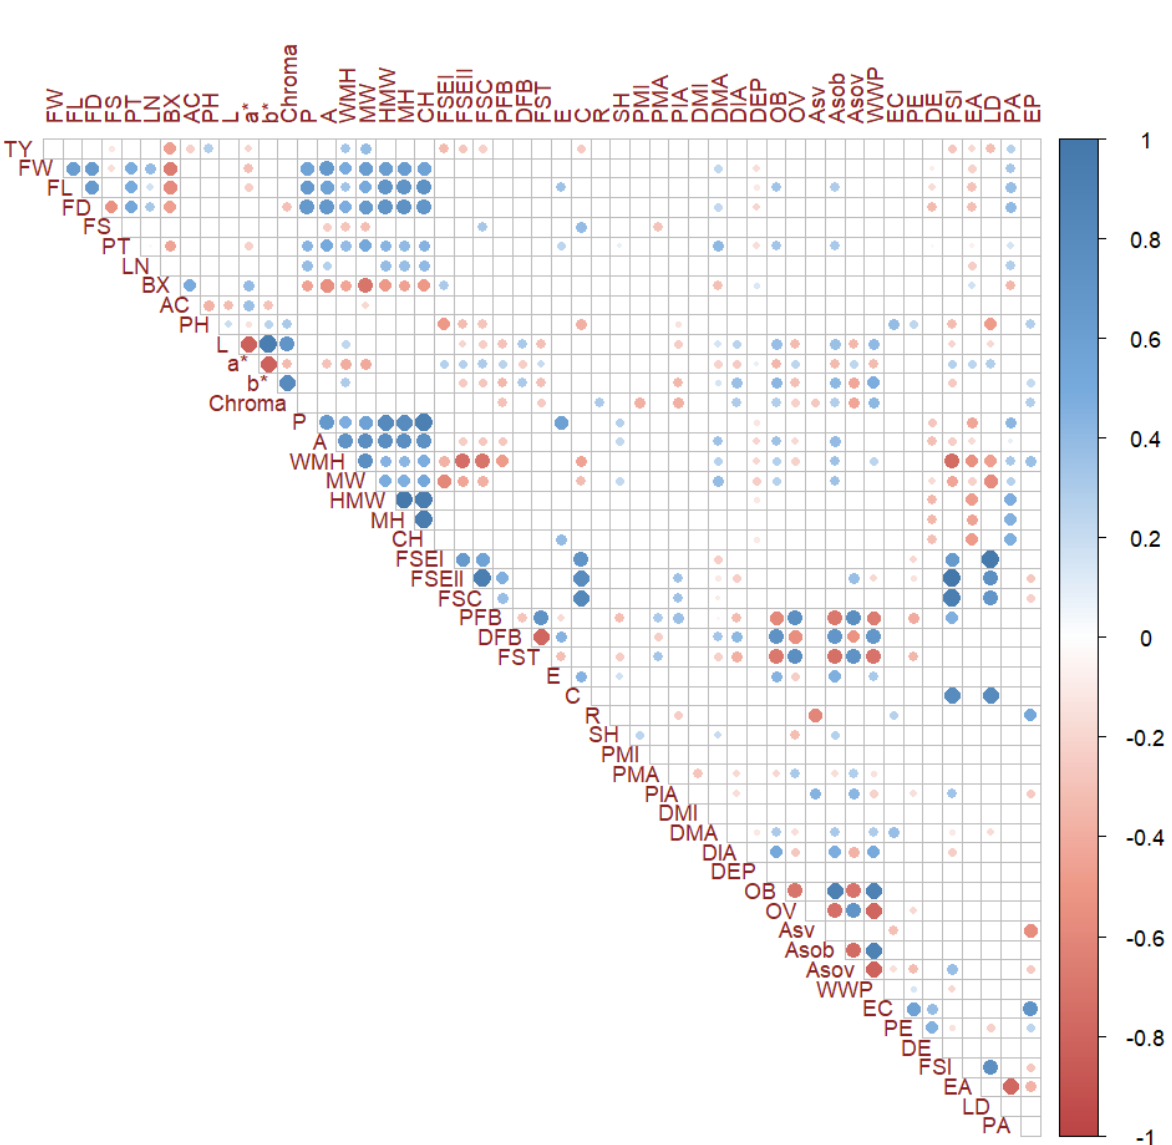
Figure 4. Pearson’s rank correlation coefficients between morpho-agronomic, chemical, and fruit imaging traits. Only correlation coefficients with p < 0.05 after Bonferroni correction are shown. Dot dimensions and colour intensity are proportional to the correlation coefficients. On the right side of the correlogram, the legend colour shows the correlation coefficients and the corresponding colours: in red, negative correlations; in blue, positive correlations.